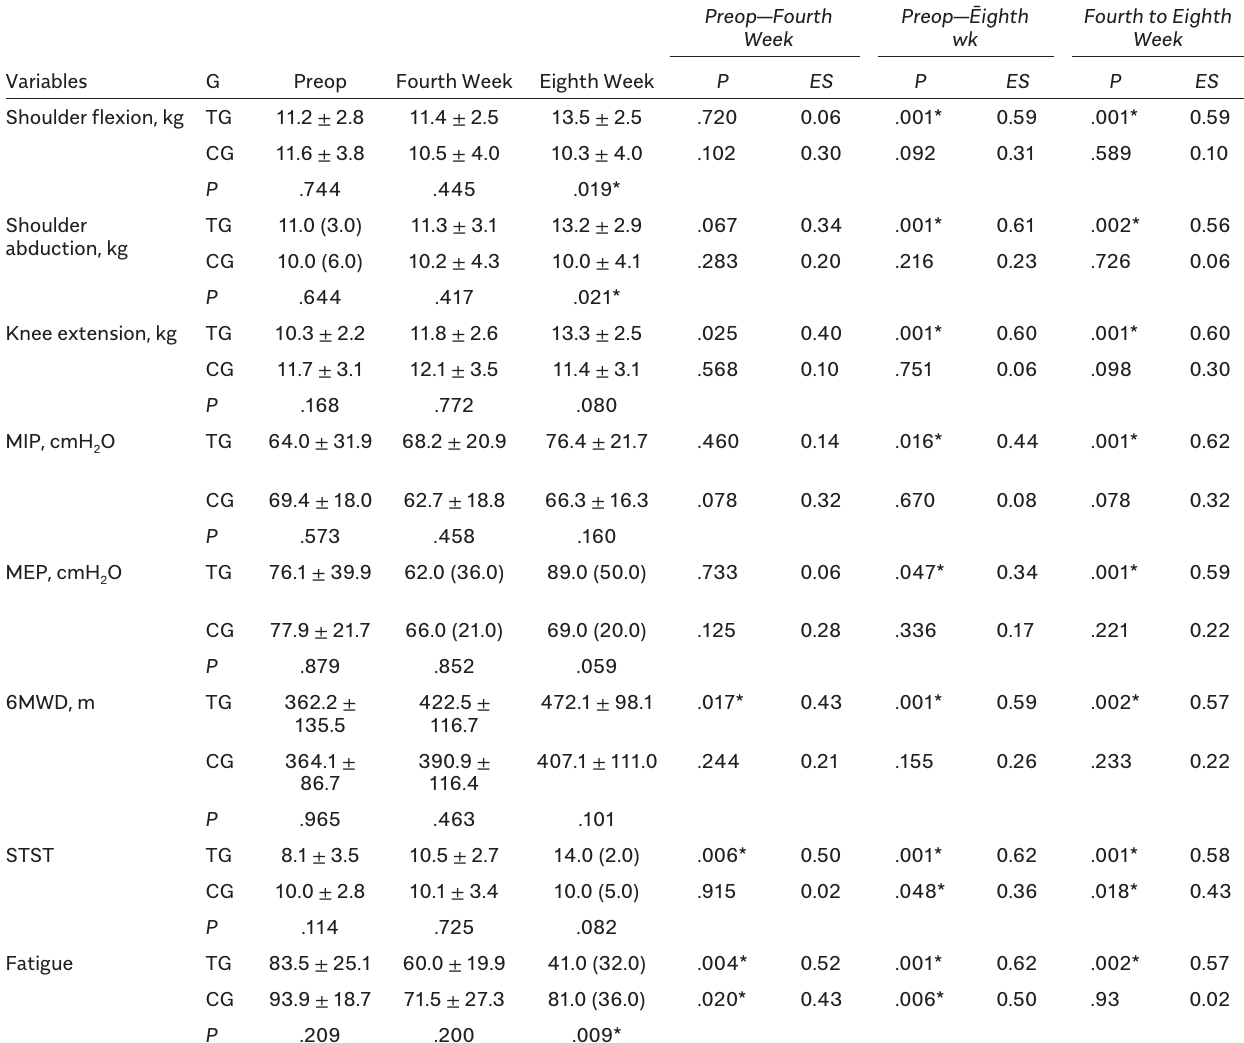
Table 2. The Comparison of the 4- and 8-Week Changes in the Outcome Measure Variables Between and Within Groups